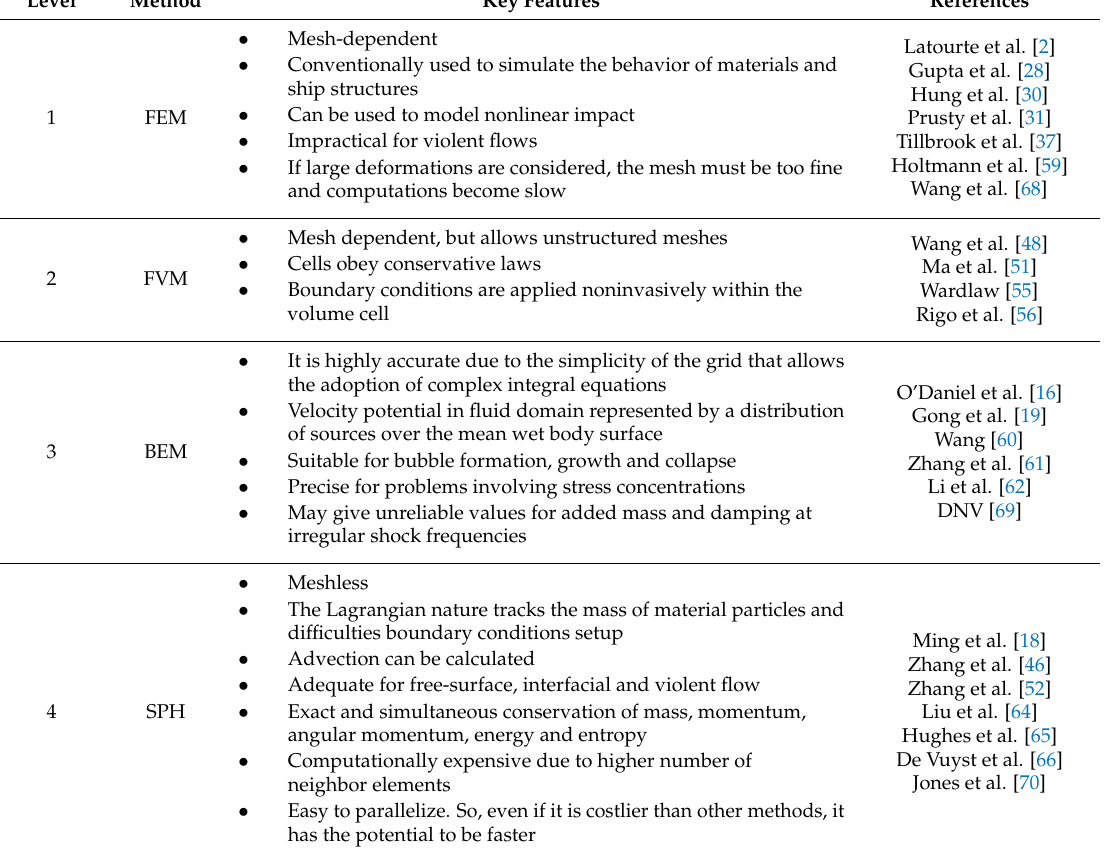
Table 1. Taxonomy of hydrodynamic modelling methods as a function of their discretization dependency. Level